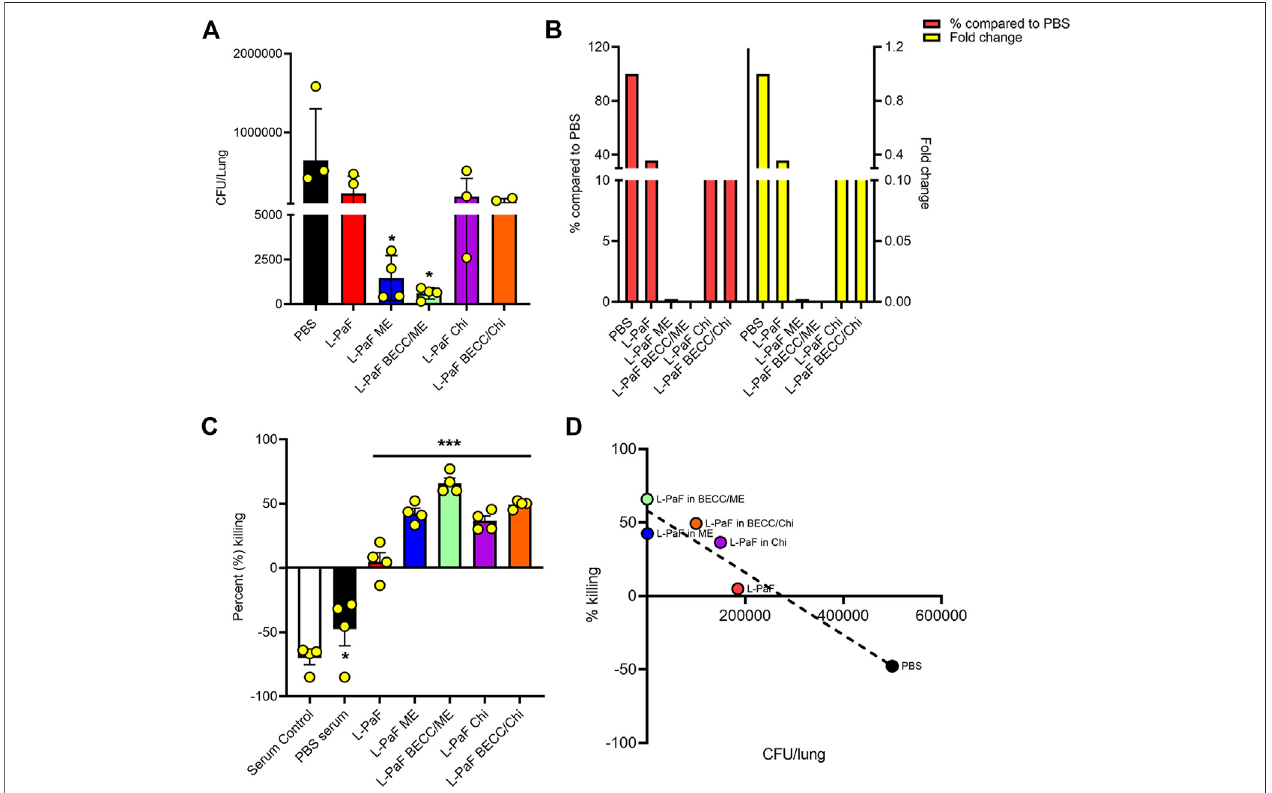
FIGURE7 | In vivo and in vitro protectiveef fi cacy studies. For in vivo ef fi cacy studies, on day 56 post immunization,micewere challenged INwithmucoid Pastrain mPa08-31 at a concentration of 4x10 7 CFU/30µl/mouse and CFU/lung were determined on three DPI (Days Post Infection) (n (cid:2) 4) (A) . The relative lung burdens were compared to PBS and the fold-change was then calculated (B) . For in vitro ef fi cacy studies, an OPK assay was carried out as described in the text. Brie fl y, the murine macrophage cell line J774A.1 was combined with mPa08-31at an MOI of 0.1. Heat-inactivated serum was mixed at a ratio of 1:500. OPK activity was determined at 30min (n (cid:2) 4) (C) , which was then checked for any correlation with in vivo lung burden (D) . OPK was determined using the following formula: (T 0 -T 30 )/T 0 x100. T 0 and T 30 wereCFUsattime0and30min,respectively.Eachdotin (A) and (C) representsindividualvaluesfromeitheramouselungorOPKsamplemix.Statisticalsigni fi cance for (A) and (C) were calculated as previously explained in Figures 5 , 6 . Pearson ’ s r coef fi cient was determined for (D) to allow assessment of the correlation (r (cid:2) − 0.9538). Simple linear regression was carried out with 95% con fi dence level (R squared (cid:2) 0.9098, deviation from zero (cid:2) signi fi cant). * p < 0.05, *** p <